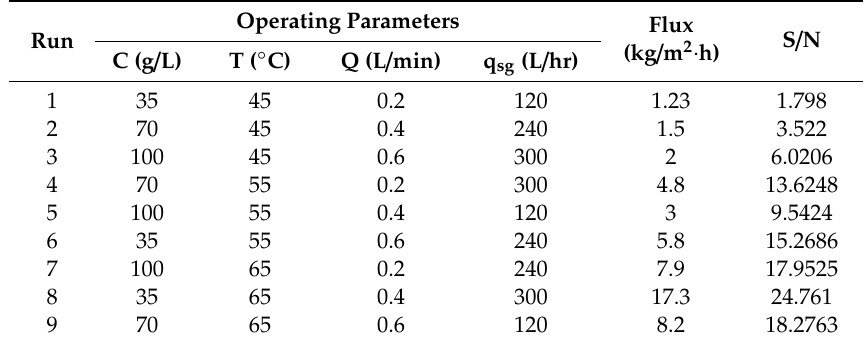
Table 6. Taguchi L 9 (3 4 ) OA, and result of experiments.